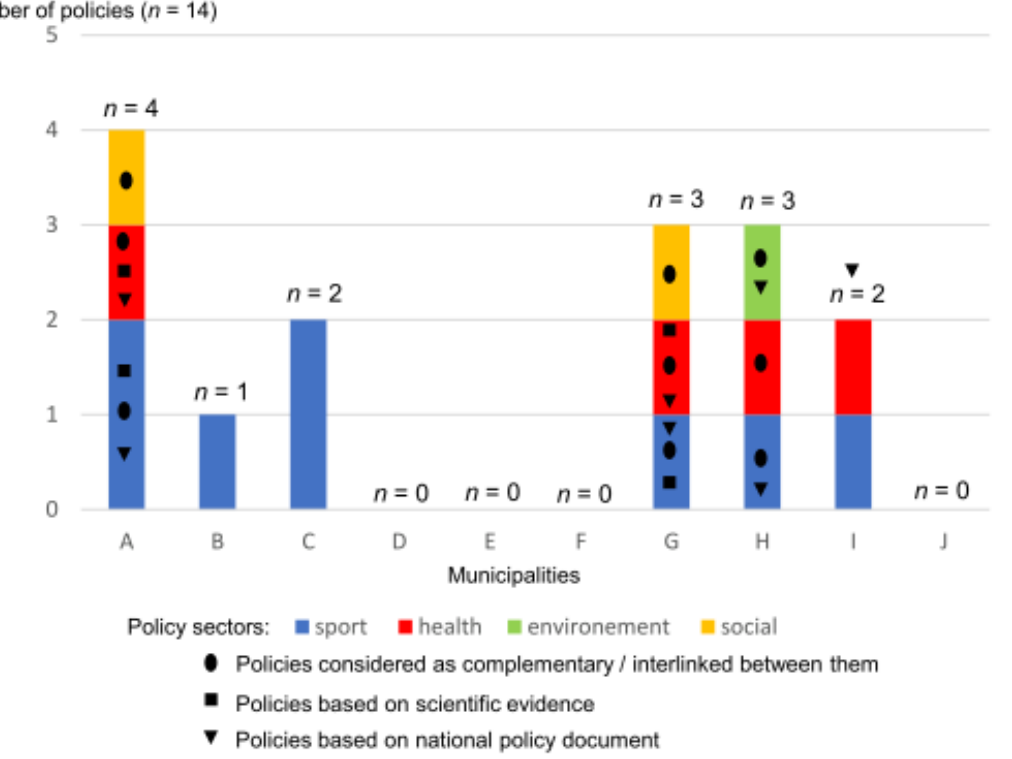
Figure 1. HEPA policy documents collected from municipalities.